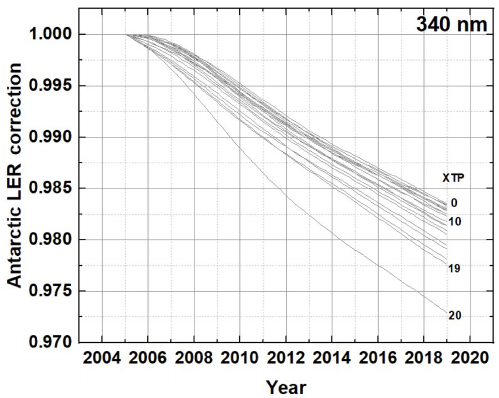
Figure A2. Correction factors for change in OMI sensitivity at 340nm by measuring ice reflectivity over the Antarctic high plateau. For cross-track positions XTP 0 to 19, the change has been less than